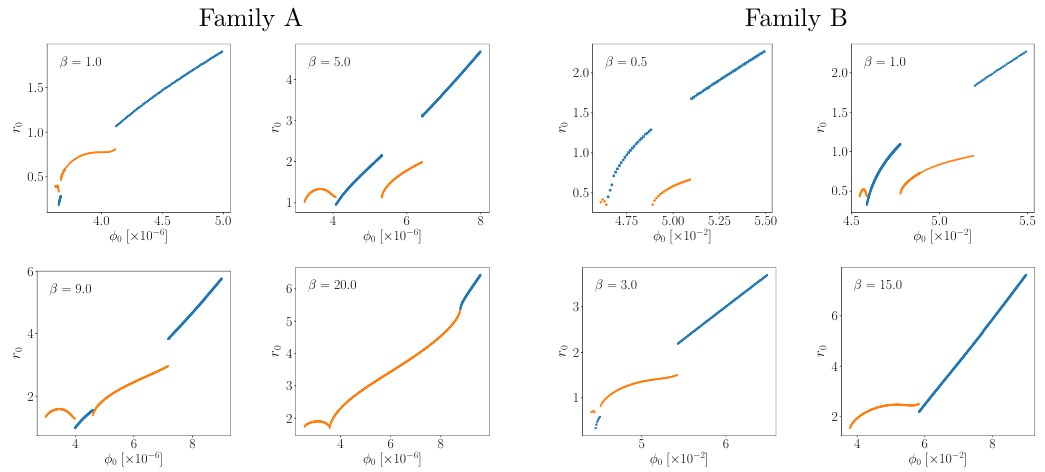
Figure 3 . Radius of the (cid:12)rst horizon formed as a function of the amplitude of the initial scalar (cid:12)eld, (cid:30) 0 , for various values of (cid:12) . Blue-branch represents formation of both horizons at the same time while orange-branch describes formation of sonic horizon only. Results are shown for Gaussian family ((cid:12)rst two columns) and the Family B initial conditions (last two